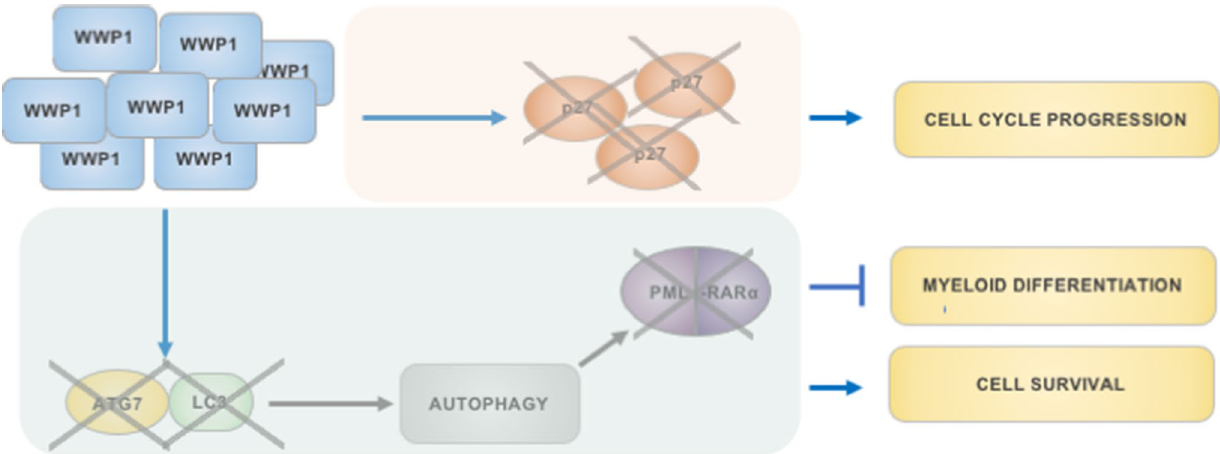
Fig. 3 A model for the outcome of WWP1 overexpression in AML blasts. Elevated amounts of WWP1 may limit the stability of the cell cycle inhibitor p27 Kip , thus promoting cell cycle progression and proliferation. WWP1 can also interfere with the basal autophagic flux, possibly by negatively regulating ATG7 and LC3 levels, hence preventing autophagy and increasing blast survival. In leukemias bearing oncoproteins (e.g. (PML-RARalpha) susceptible to autophagy-mediated disposal, WWP1 overexpression would counteract their proteolysis. As a conse- quence, WWP1 would prevent myeloid